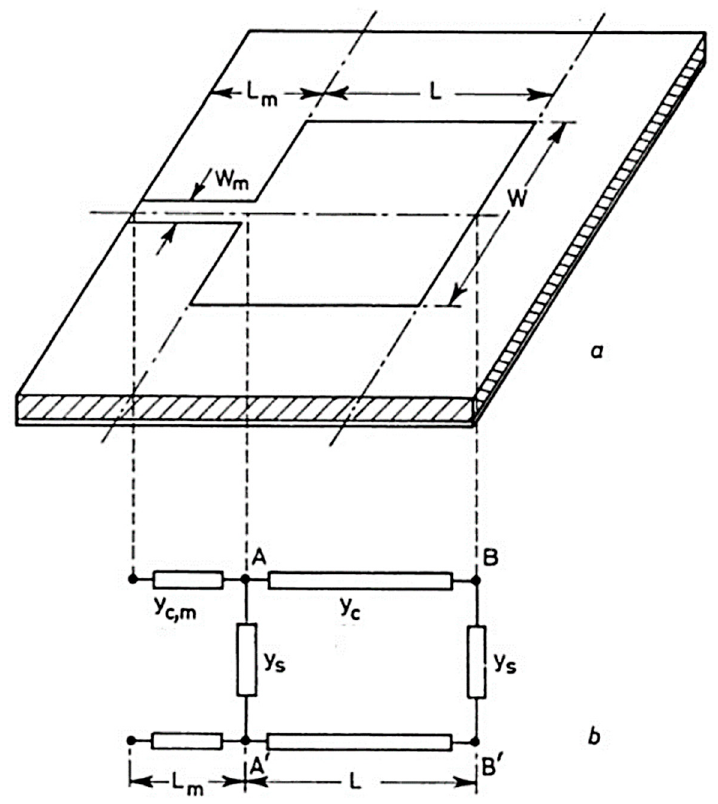
Figure 1. The TL model of a flexible microstrip antenna.